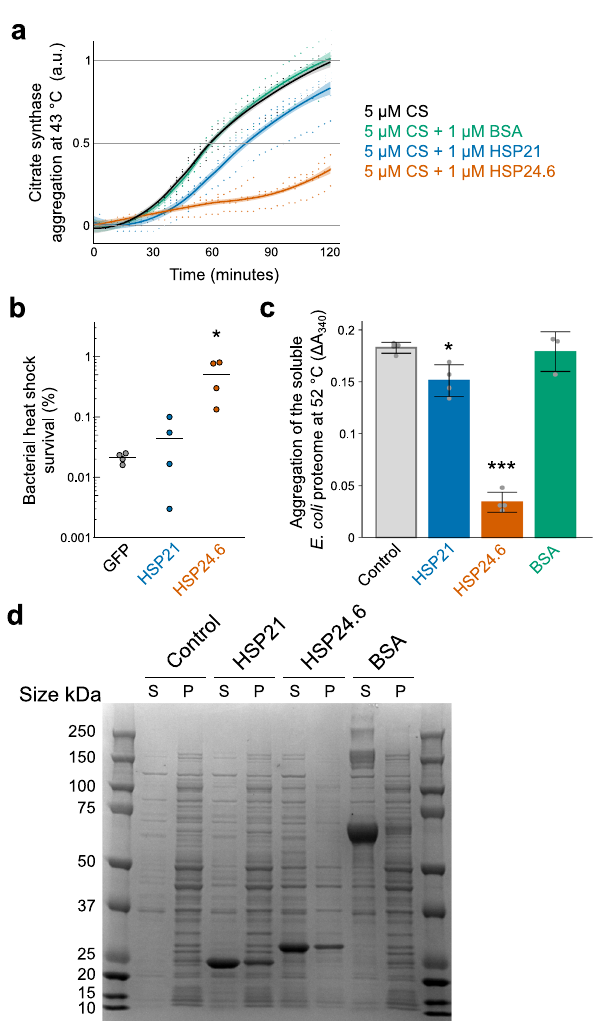
Fig. 4 Tardigrade sHSPs can chaperone against heat-induced protein aggregation. a HSP21 and HSP24.6 limit heat-induced aggregation of citrate synthase at 43 °C. Aggregation is plotted as the change in A 340 relative to that of 5 µ M citrate synthase alone at 2 h. Datapoints from four biological replicates are shown along with a fi tted line and 95% con fi dence interval. b ) Heterologous expression of HSP24.6 improved heat shock survival of BL21 E. coli ( p = 0.02, Dunnett ’ s test, n = 4). c HSP21 and HSP24.6 limited heat-induced aggregation of the water soluble BL21 E. coli proteome. In vitro aggregation of soluble protein following 1 h at 52 °C was signi fi cantly different across conditions shown ( p < 0.001, 1-way ANOVA, n = 3 – 4). HSP21 ( p = 0.01, Dunnett ’ s test, n = 4) and HSP24.6 ( p < 0.001, Dunnett ’ s test, n = 4) reduced aggregation, while BSA ( p = 0.96, n = 3, Dunnett ’ s test) did not have an effect. sHSPs or BSA were added at a 1:1 mass ratio with E. coli protein. d ) Soluble (supernatant, S) and insoluble (pellet, P) protein fractions were assessed by SDS-PAGE. A representative Coomassie-stained gel shows soluble and insoluble protein following heat shock at 52 °C for 1 h. The pelleted insoluble fraction was concentrated 4× before loading. * p < 0.05, *** p <